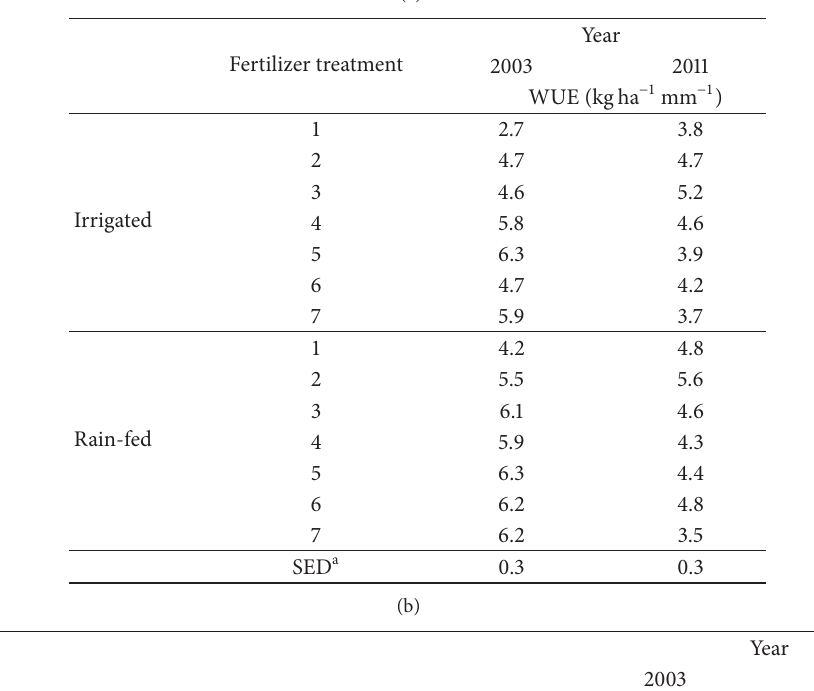
Table 9: Water use efficiency (WUE) means and selected contrasts by year for plots with different fertilizer treatments and those either received a flush of irrigation prior to planting or did not receive irrigation.